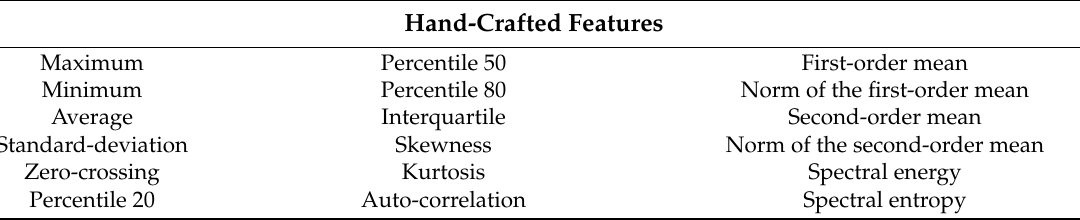
Table 4. List of the hand-crafted features used in our study. Each feature is computed on each sensor channel